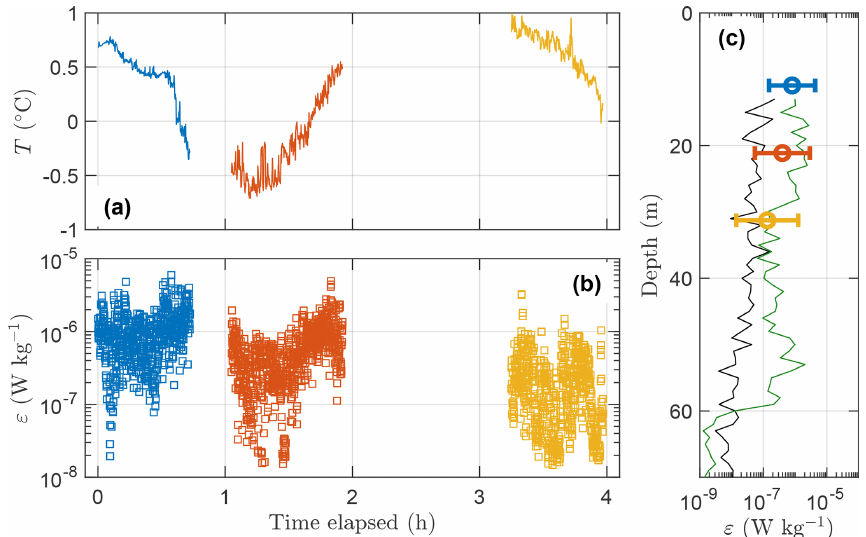
Figure 8. Overview of dissipation rates. Time series of (a) temperature and (b) final estimate of the dissipation rate. (c) Vertical profiles (black and green) of ε measured by the vertical microstructure profiler at two co-located stations marked by stars in Fig. 1b. Mean value and the lower and upper limits (95% confidence intervals) of the natural logarithm of the AUV–MR measurement are shown at their corresponding average depth in (c) . Blue, red and yellow correspond to 11, 21 and 31m depth,